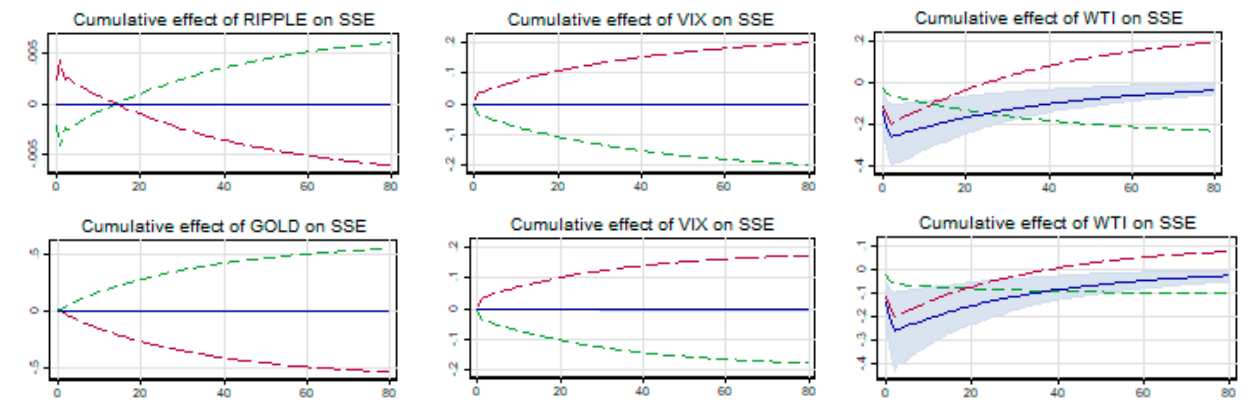
Figure 5. Cumulative effects of cryptos and gold on RTSI.